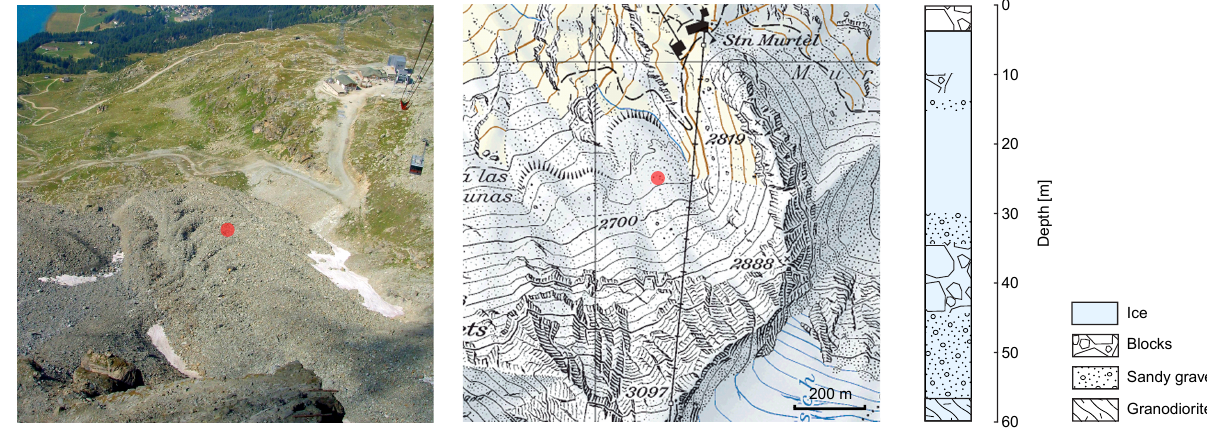
Figure 1. Field site photograph, situation map (reproduced by permission of swisstopo (BA14029)), and approximative stratigraphy (accord- ing to Arenson et al., 2002) indicating the depth of the permafrost table. The red dot shows the location of the borehole and the meteorological